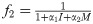
Data fitting for the daily number of hospital notifications from September 3rd to 21st, 2009 in the 8th hospital of Xi’an.Circles represent the hospital notifications in the 8th hospital of Xi’an, black curve, red curve and blue curve represent the estimating solutions for the number of infected individuals in system (1) without media impact (i.e. f0 = 1), and by using media function f1 = e−α1I−α2M, f2=11+α1I+α2M, respectively.